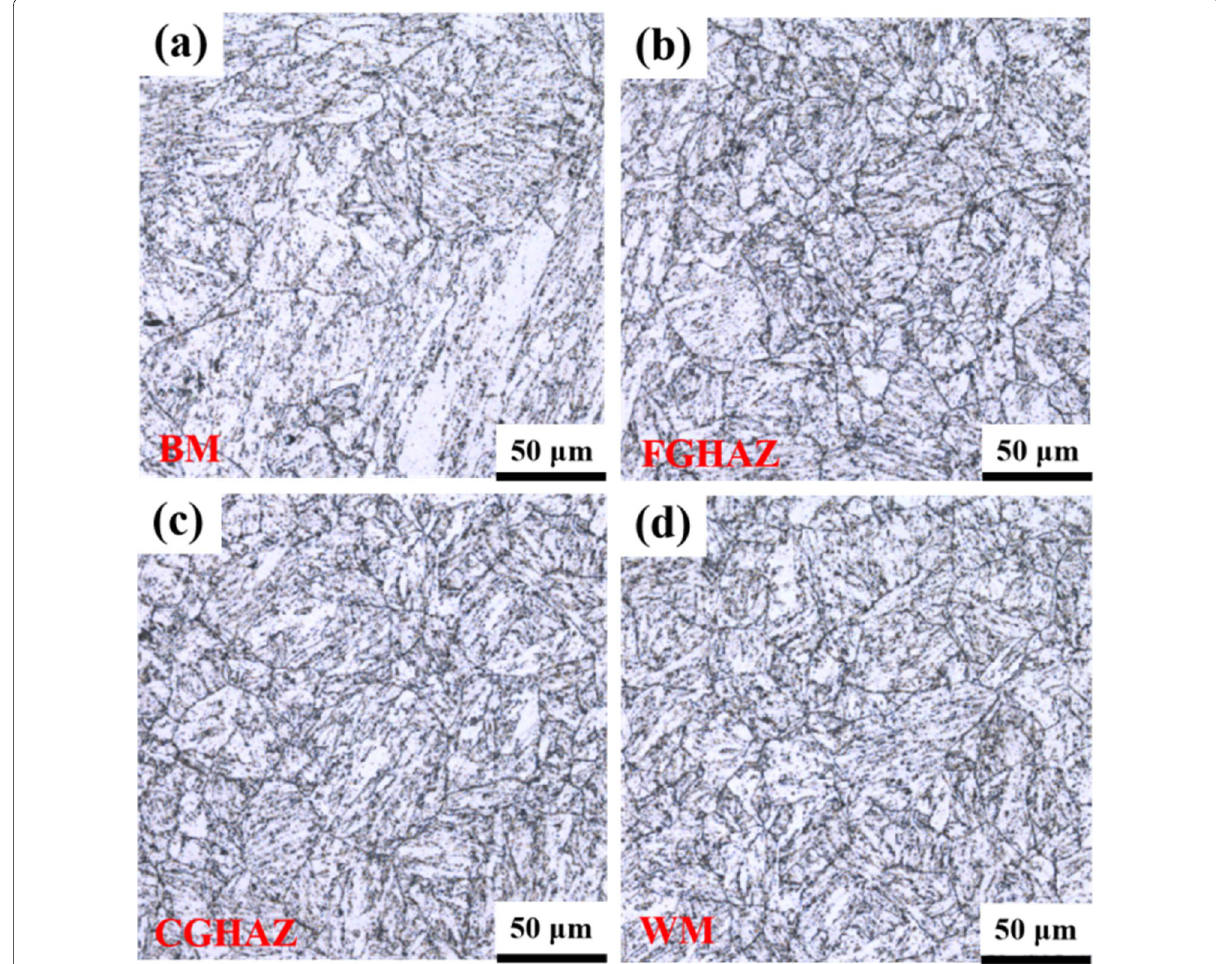
Figure 1 Microstructures in the ( a ) BM, ( b ) FGHAZ, ( c ) CGHAZ and ( d ) WM regions for PWHT weld joint